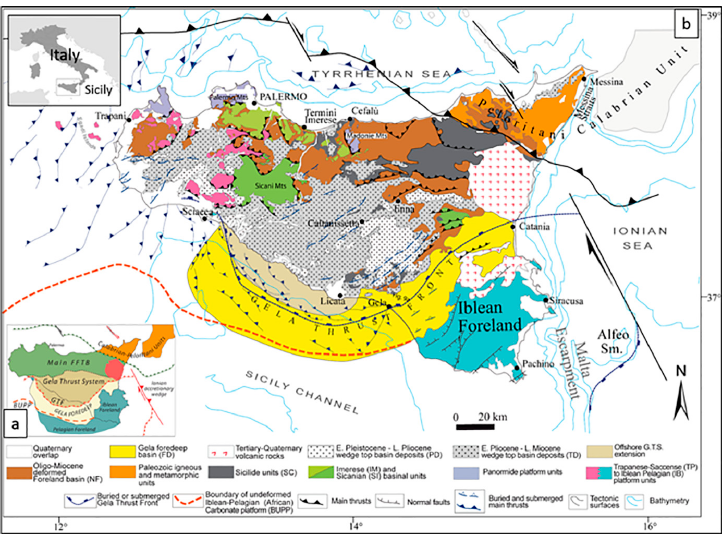
Figure 1. Schematic structural map of Sicily [17]. ( a ) The three main geological structural elements of Sicily; ( b ) distribution of the main stratigraphic–structural